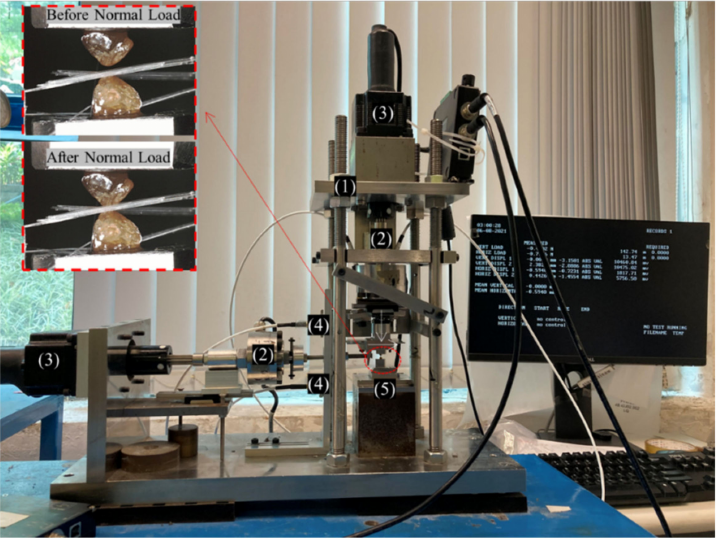
Figure 4. Micromechanical apparatus and the arrangement of specimen (inset). (1) Rigid frame, (2) Load cells, (3) Linear actuators, (4) non-contact displacement transducers, (5) fixed bottom grain (after